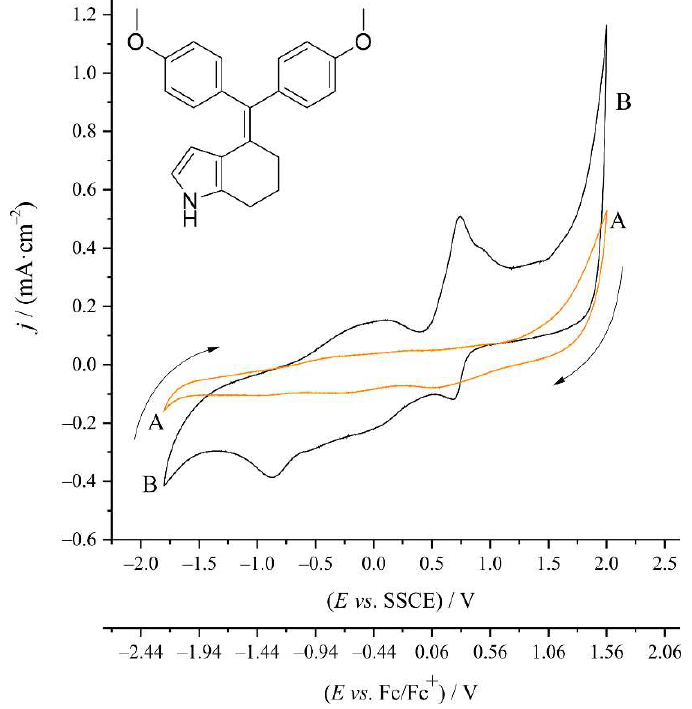
Figure 1. Cyclic voltammograms recorded at Pt (surface area A = 8.1 mm 2 ) in contact with (A) 0.1 M Bu 4 NClO 4 in MeCN (blank solution (orange curve)) (B) 0.1 M Bu 4 NClO 4 + 1 mM 42 in MeCN. Scan rate: v = 1 V/s .